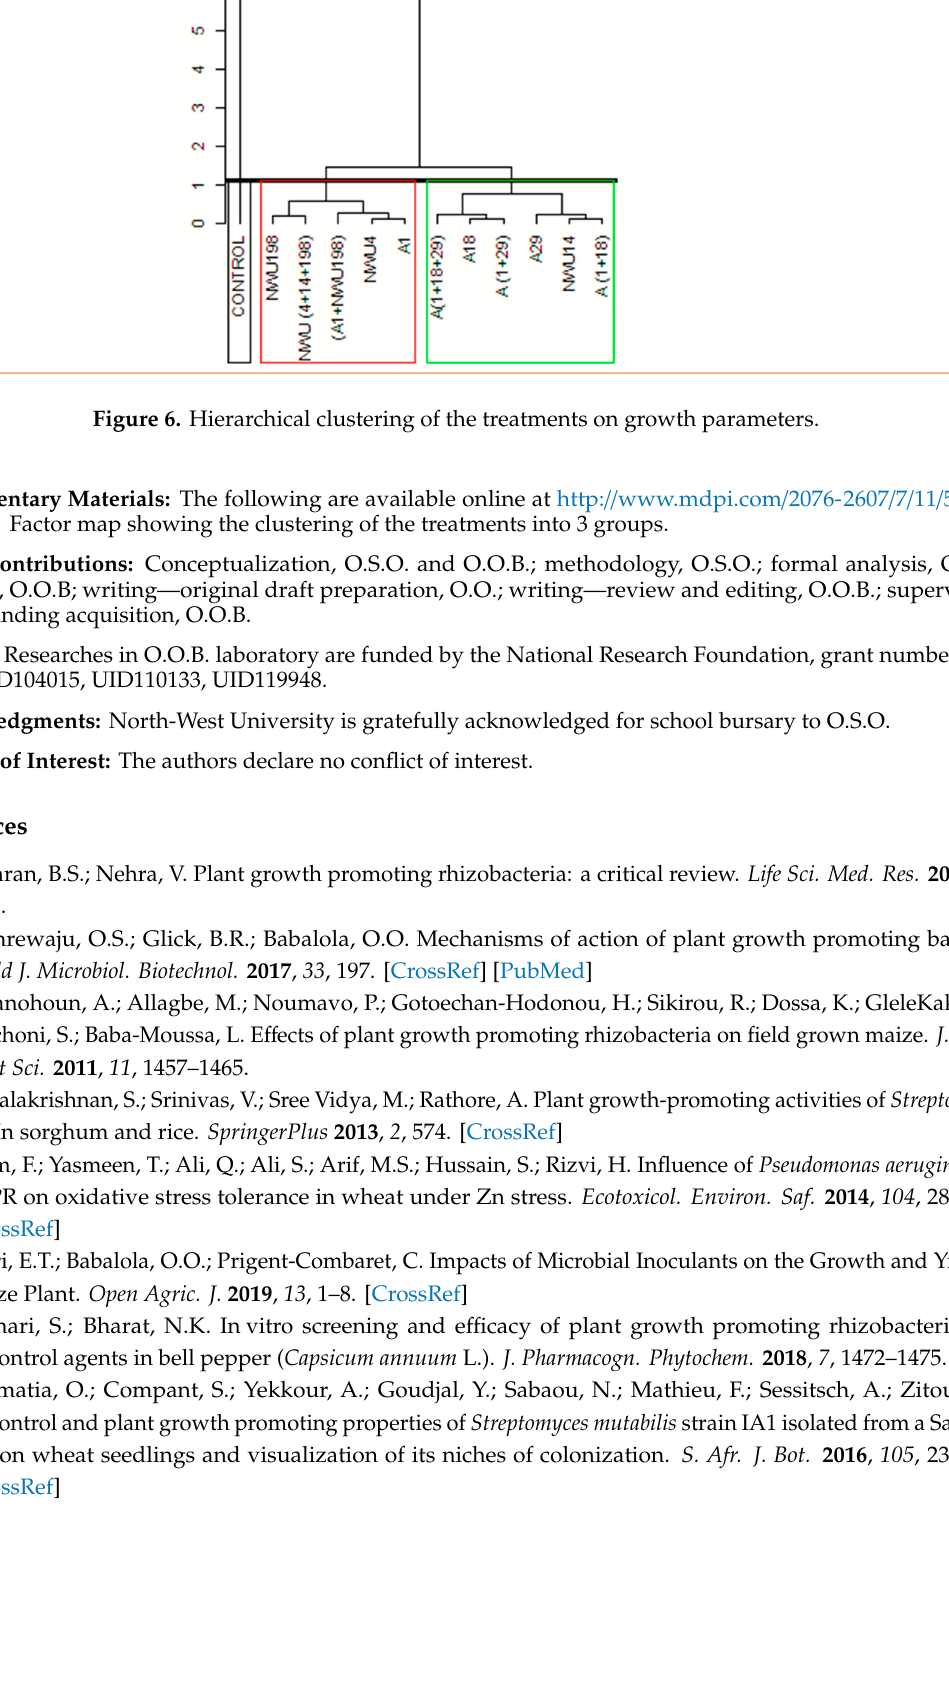
Figure 5. Principal component analysis of growth traits in maize.